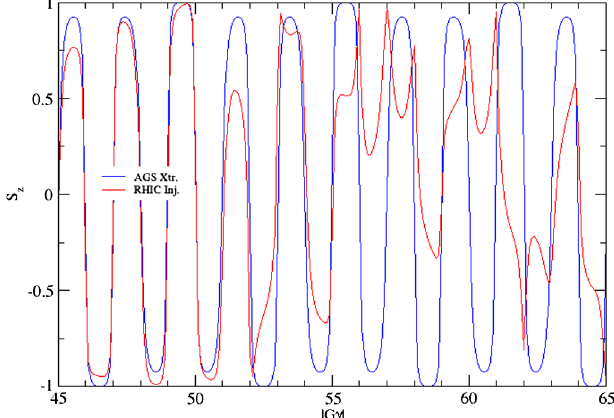
FIG. 5. The directional cosine S of the stable spin direction at z the AGS extraction point (blue trace) and at the RHIC injection point (red trace) as a function of j G γ j . There is considerable mismatch between the stable spin direction at the exit of the AtR line and that at the RHIC injection point for j G γ j > 51 . 5